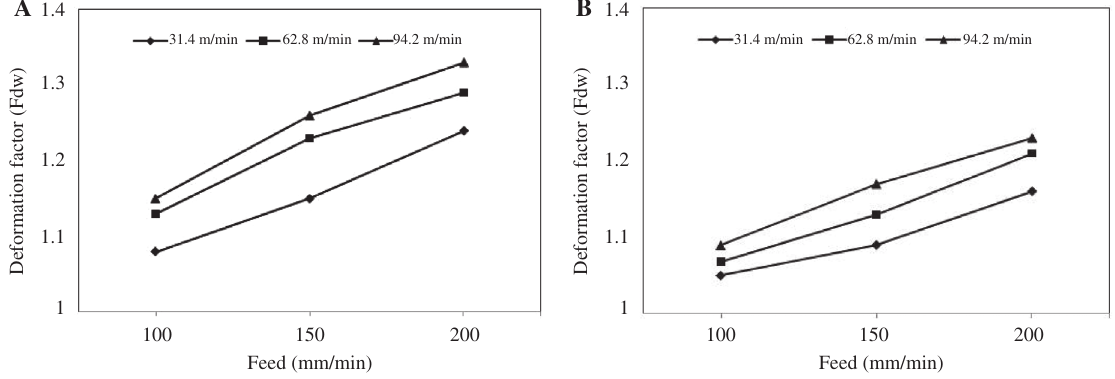
Figure 6 Influence of the cutting parameters on delamination factor at different number of flutes: (A) three flutes and (B) four flutes.